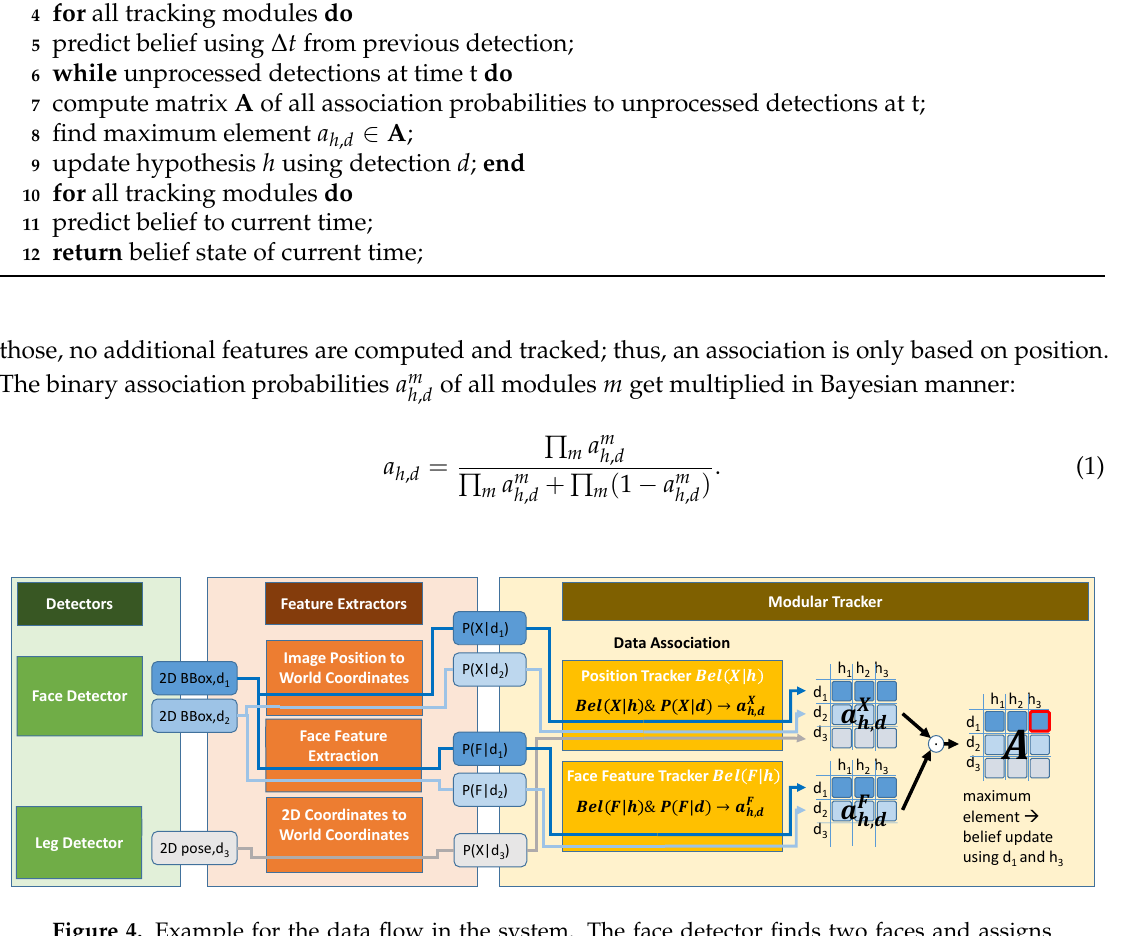
Figure 4. Example for the data flow in the system. The face detector finds two faces and assigns Detection IDs d 1 and d 2 . In the range scan, one person has been detected ( d 3 ). The Detection ID is used for assignment of the data association results of the individual tracker modules. Since each module uses a common set of Hypothesis IDs ( h i ), the matrices A X for the position-based association probabilities and A F for the face feature-based association can be multiplied element-wise in order to find the best combination of detection and hypothesis to be used for a belief